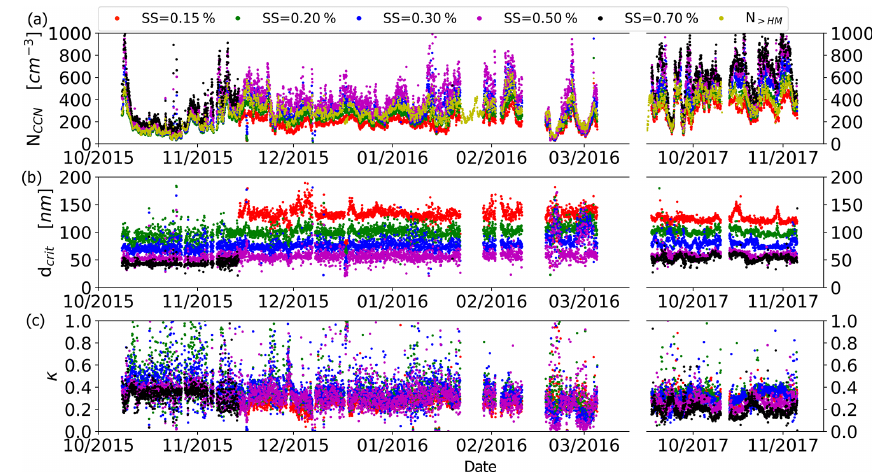
Figure 3. Time series of N CCN in panel (a) , d crit in panel (b) and κ in panel (c) with 1h resolution at each supersaturation. Red, green, blue, purple and black dots indicate supersaturations (SS) of 0.15%, 0.20%, 0.30%, 0.50% and 0.70%, respectively. Yellow dots in the upper panel show the time series of particle number concentration for particles larger than the Hoppel minimum diameter ( N > HM